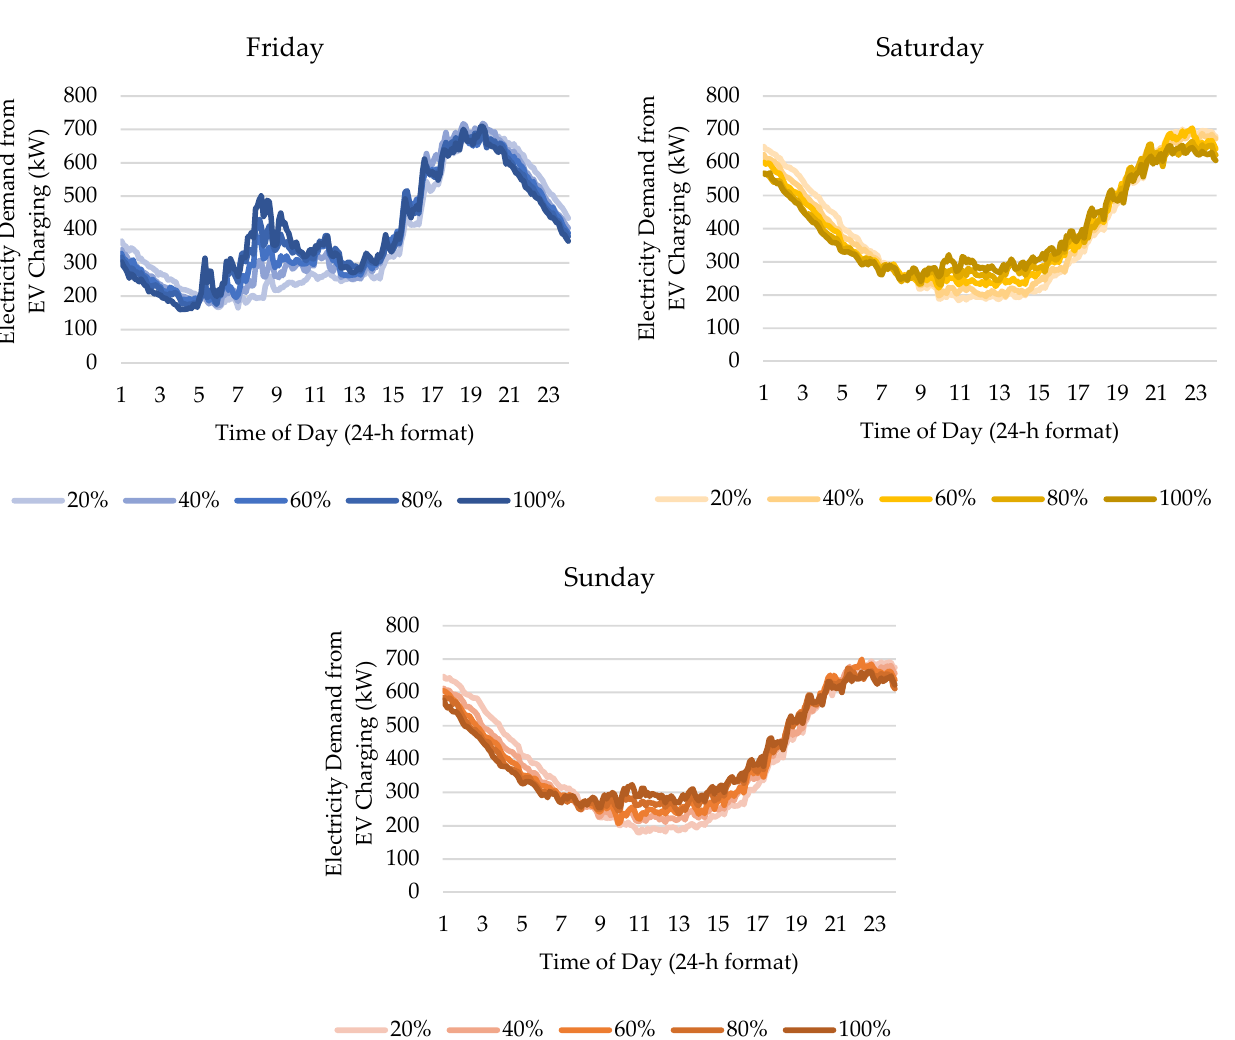
Figure 4. Effect of increasing EVSEs outside homes. Darker curves refer to higher percentage availability.